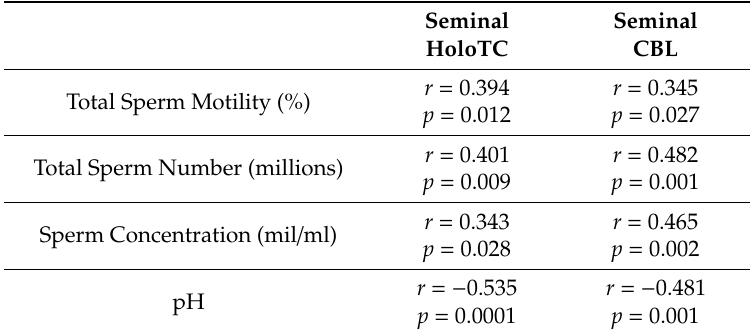
Table 4. Correlations between seminal holoTC or CBL and seminal parameters. r and p values of Spearman’s correlation are indicated. The analysis was performed on the whole